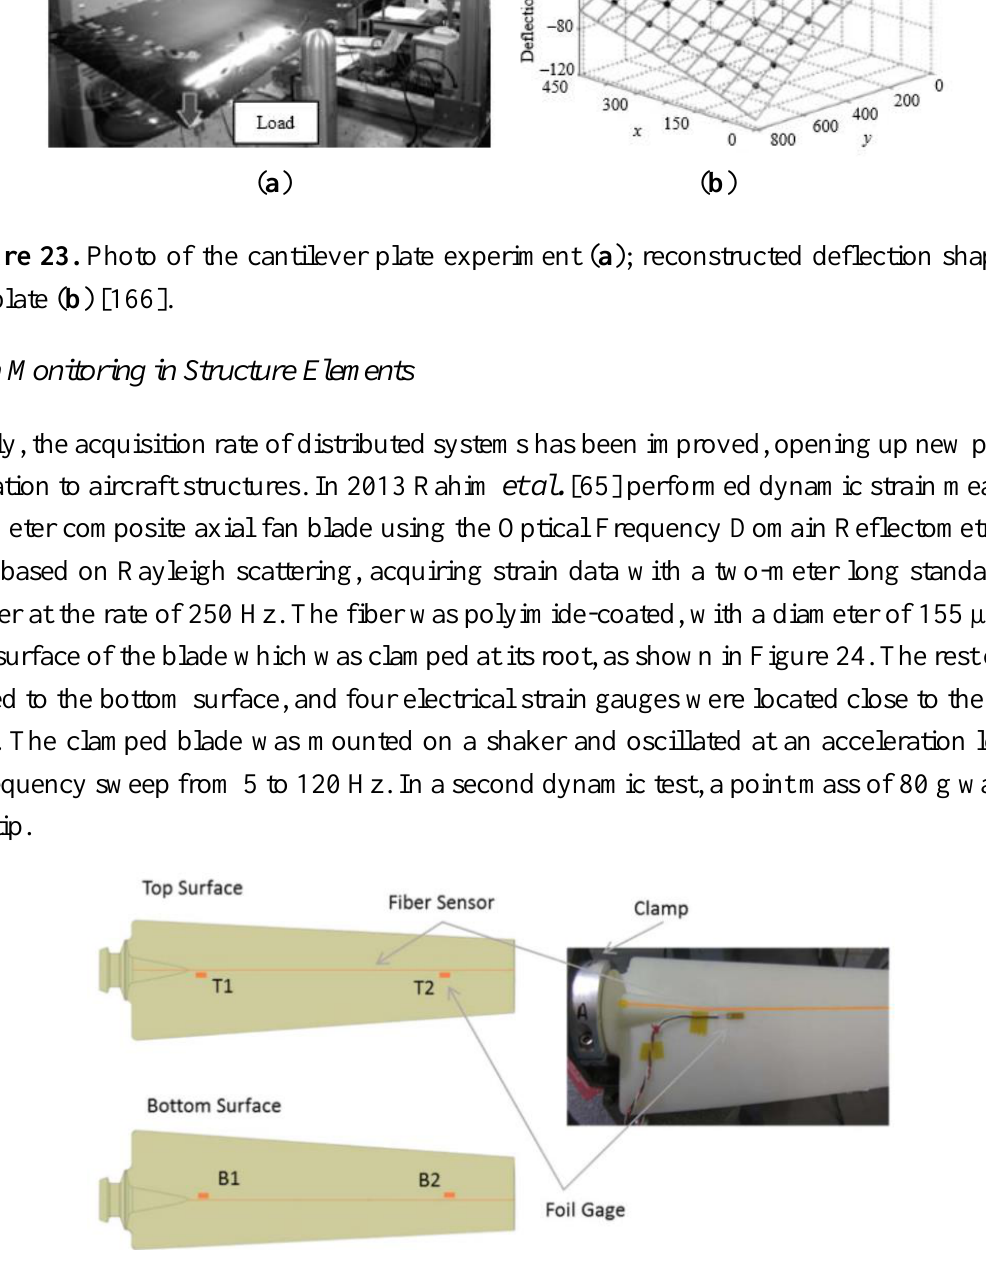
Figure 24. Position of the optical fiber and foil gage in the clamped fan experiment